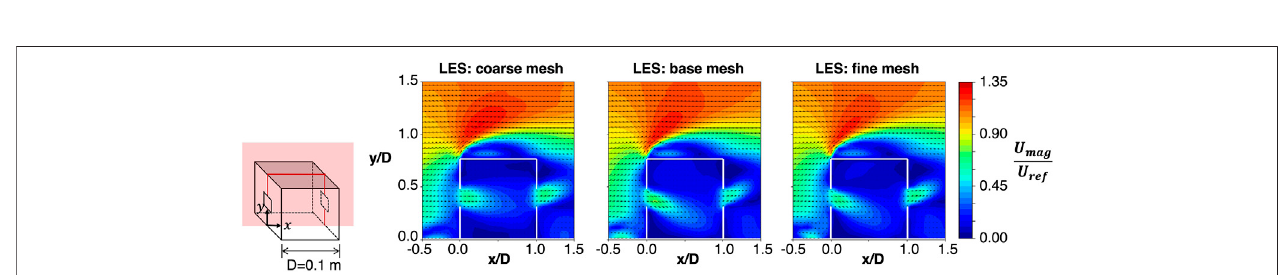
FIGURE3| Graphicalrepresentationofageofaircalculation: (A) Concentrationdecaycurveforpassivescalaratthecenterofhouse;and (B) indoorconcentration at four time steps.